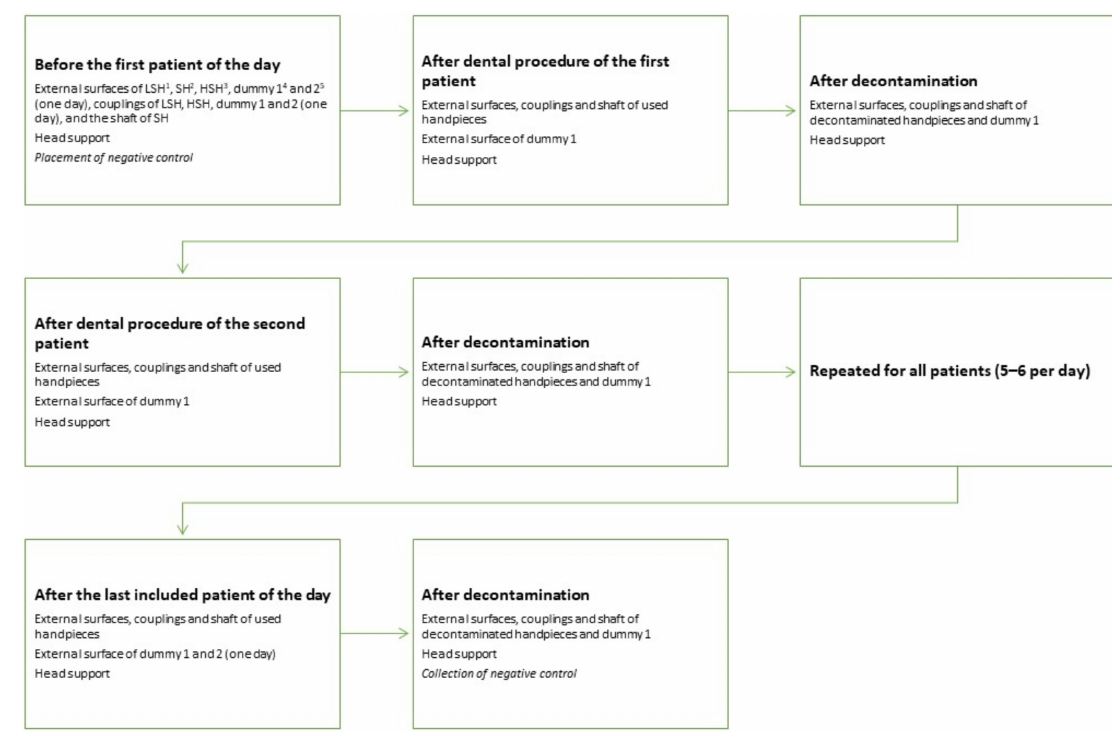
Figure 2. Sampling schedule for the equipment. For assessment of environmental contamination one or two extra LSH (called dummy 1 and 2) and the head support were sampled. The dummies were not used during dental procedure, but consisted of one or two extra handpieces placed close by if needed during the procedure (approximately 70 cm from the patient’s oral cavity). Sampling after dental procedure was carried out within 5 min after the dental procedure was finished and no equipment was rinsed or wiped off before sampling. 1 NSK Ti-Max X25, 2 W&H S-15, 3 Pferdefit-Dental Eco high